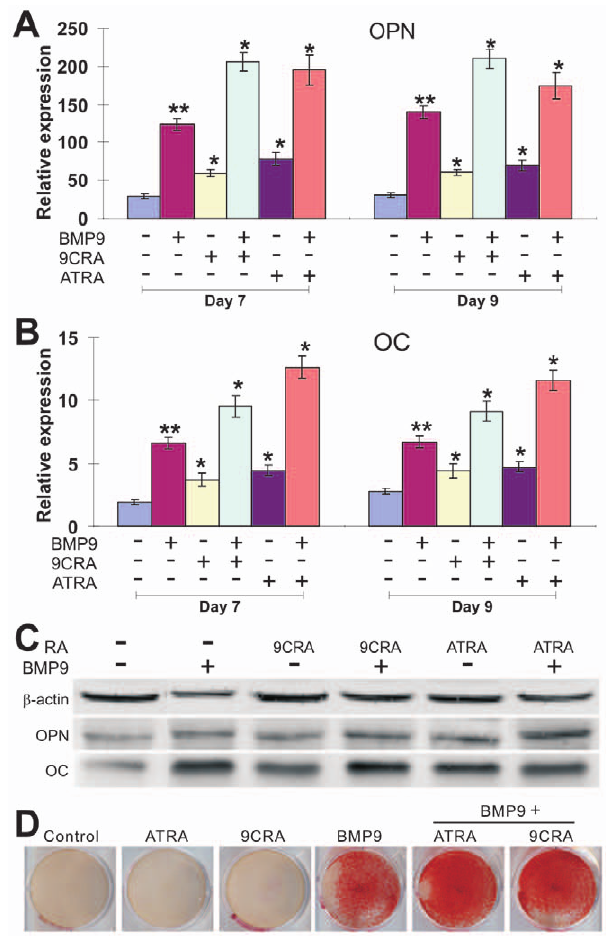
Figure 3. Retinoids potentiate BMP9-induced late osteogenic markers and matrix mineralization in MPCs. ( A ) qPCR analysis of retinoic acids and BMP9 induced osteopontin (OPN) expression. Subconfluent MEFs were infected with AdBMP9 or AdGFP (i.e., -BMP9 groups, MOI=5), and then treated with 9CRA (20 m M), ATRA (20 m M), or solvent control. At day 7 and day 9, the cells were collected for total RNA isolation. RNA was subjected to RT-PCR transcription, which was used as templates for qPCR analysis using primers specific for mouse OPN. Each assay condition was carried out in triplicate. All samples were normalized using endogenous levels of GAPDH. ‘‘*’’, p , 0.05 ; ‘‘**’’, p , 0.01 (vs. control groups). ( B ) qPCR analysis of retinoic acids and BMP9 induced osteocalcin (OC) expression. Samples prepared in (A) were used for qPCR analysis using primers specific for mouse OC. Each assay condition was carried out in triplicate. ‘‘*’’, p , 0.05 ; ‘‘**’’, p , 0.01 (vs. control groups). ( C ) Western blotting analysis of retinoic acids and BMP9 induced OPN and OC expression. MEFs were infected with AdBMP9 or AdGFP (i.e., -BMP9 groups, MOI=5), and then treated with 9CRA (20 m M), ATRA (20 m M), or solvent control. At day 7, cells were lysed and subjected to Western blotting analysis using anti-OPN or anti- OC antibody (Santa Cruz Biotechnology). Anti- b actin antibody was used to demonstrate equal loading of all samples. ( D ) Retinoic acids and BMP9 induce matrix mineralization. MEFs were infected with AdBMP9 or AdGFP (i.e., -BMP9 groups, MOI=5), and then treated with 9CRA (20 m M), ATRA (20 m M), or solvent control. At day 14, cells were subjected to Alizarin Red S staining. Experiments were carried out in duplicate and representative results are